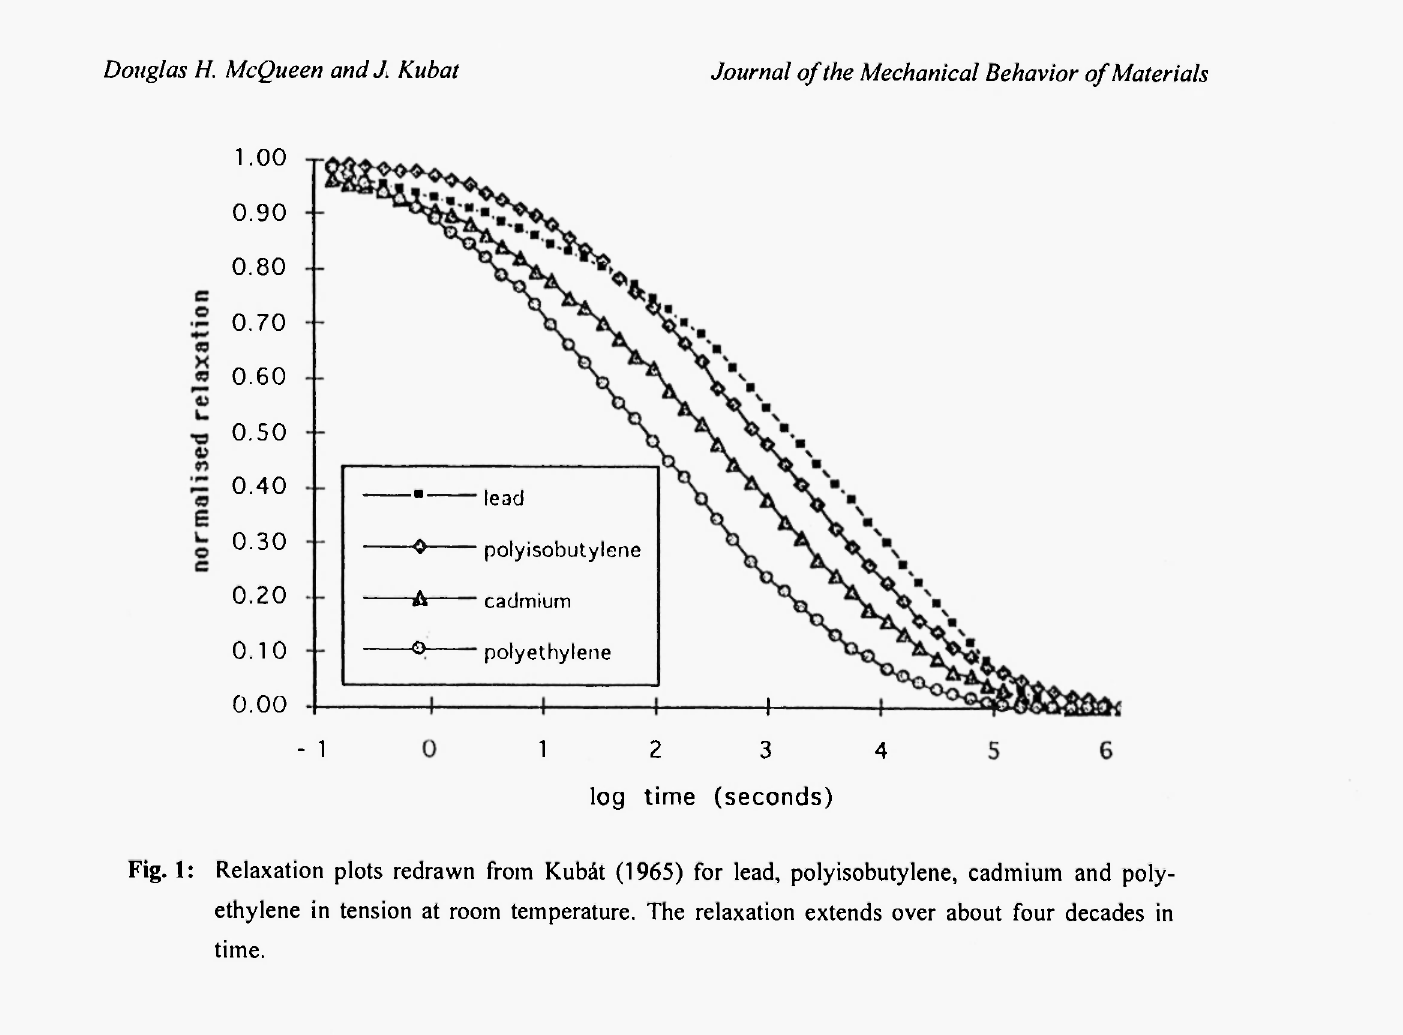
Fig. 1: Relaxation plots redrawn from Kubät (1965) for lead, polyisobutylene, cadmium and poly- ethylene in tension at room temperature. The relaxation extends over about four decades in